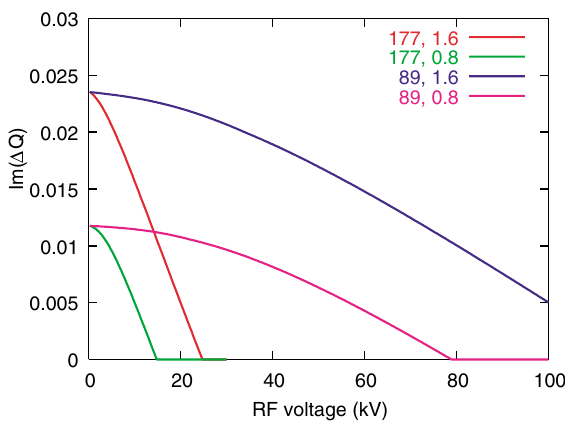
FIG. 13. (Color) Maximum growth rate versus rf voltage for PSR with 6 : 4 (cid:16) C and various values of bunch length and electron line